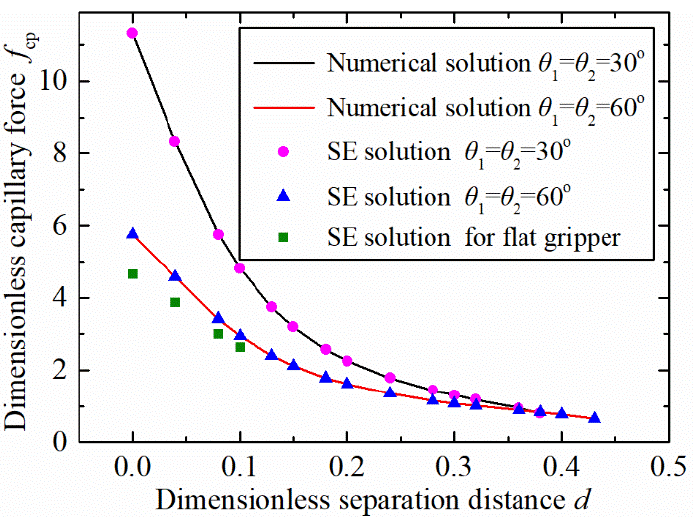
Figure 8. Comparation results between numerical and Surface Evolver (SE) solutions.